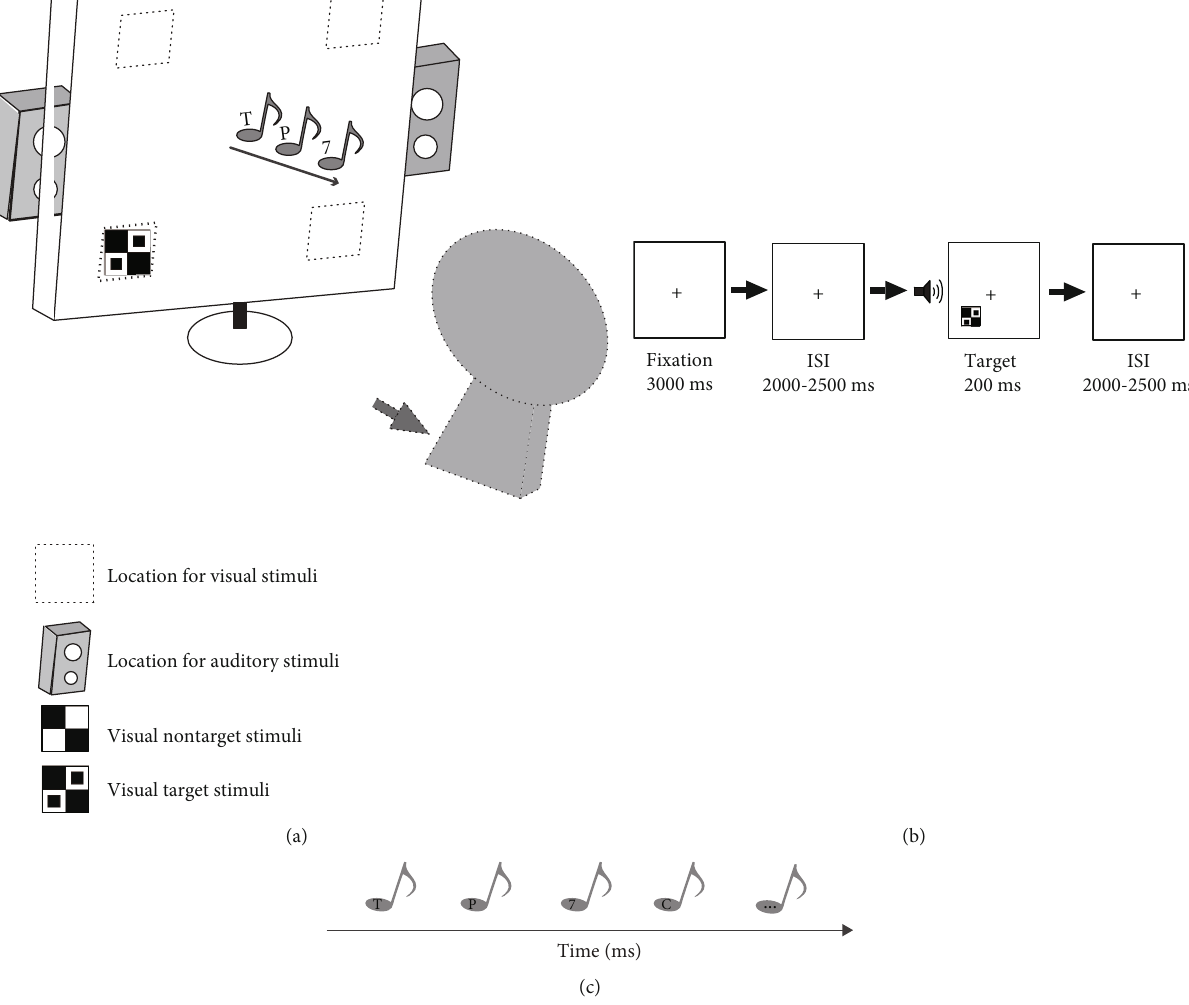
Figure 1: (a) The experimental scenario; a possible sequence for the (b) AV discrimination task and the (c) RSAP task. The AV discrimination task and RSAP task were presented